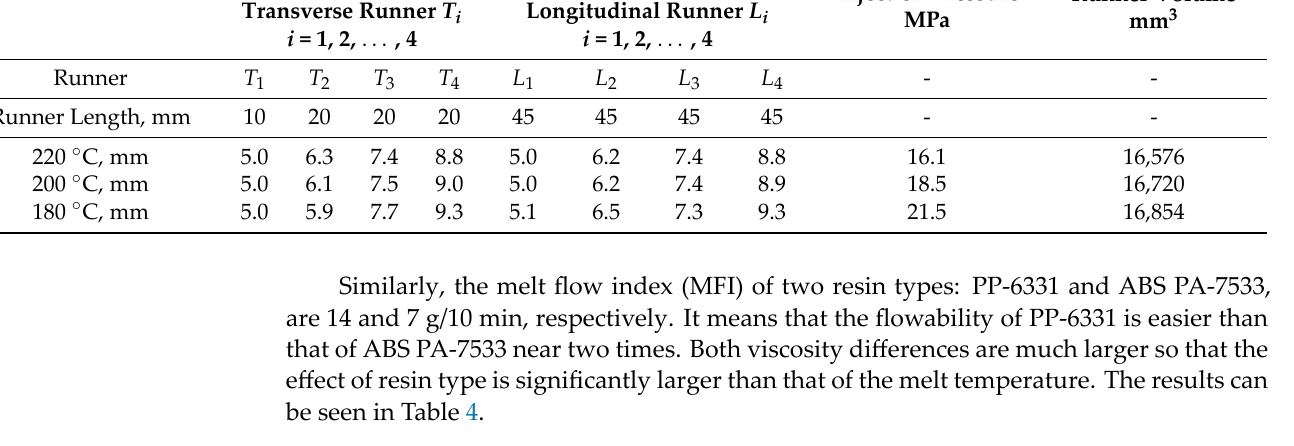
Table 4. Optimal diameters of the runner system and injection pressure with respect to different resin